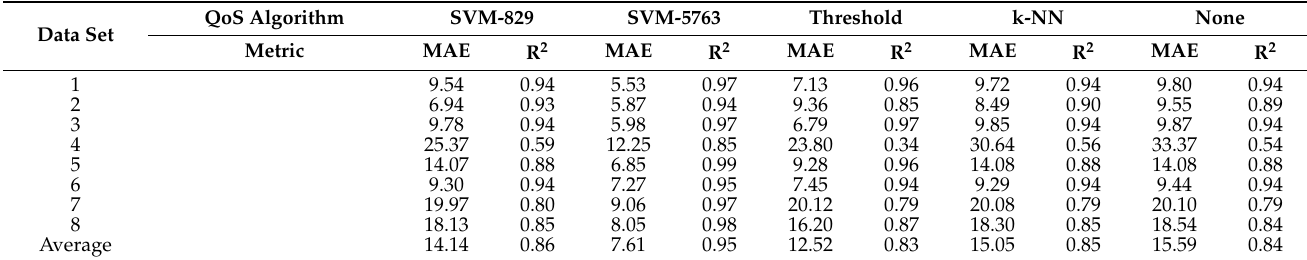
Table 6. Prediction of angle with data quality indication algorithms and without data quality indication. QoS Algorithm Data Set